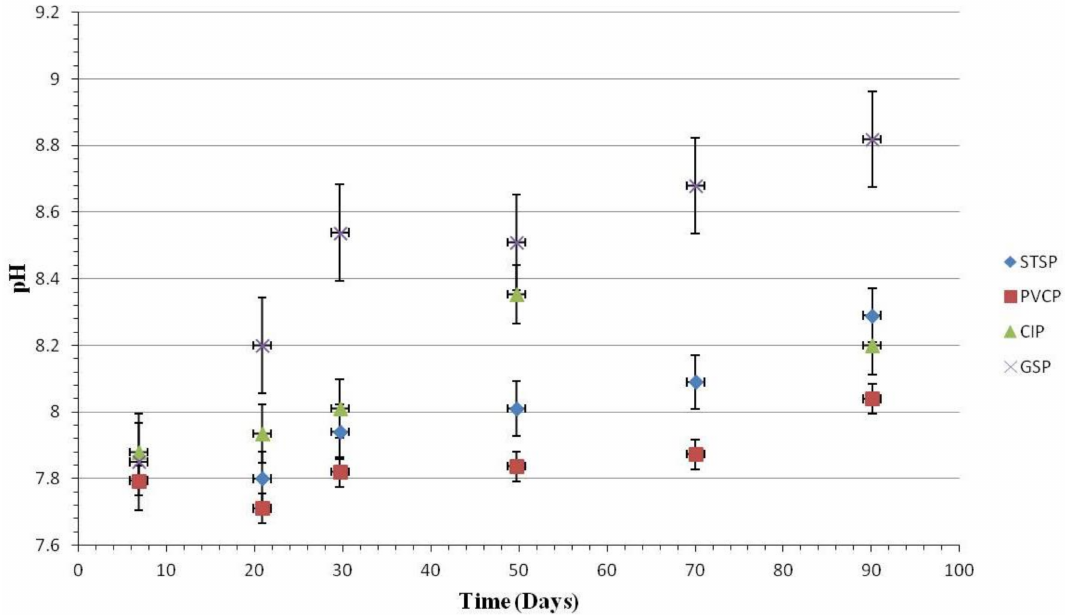
Figure 3. Variations of pH in RW in stainless steel, polyvinyl chloride, cast iron, and galvanized steel pipes over time with standard error